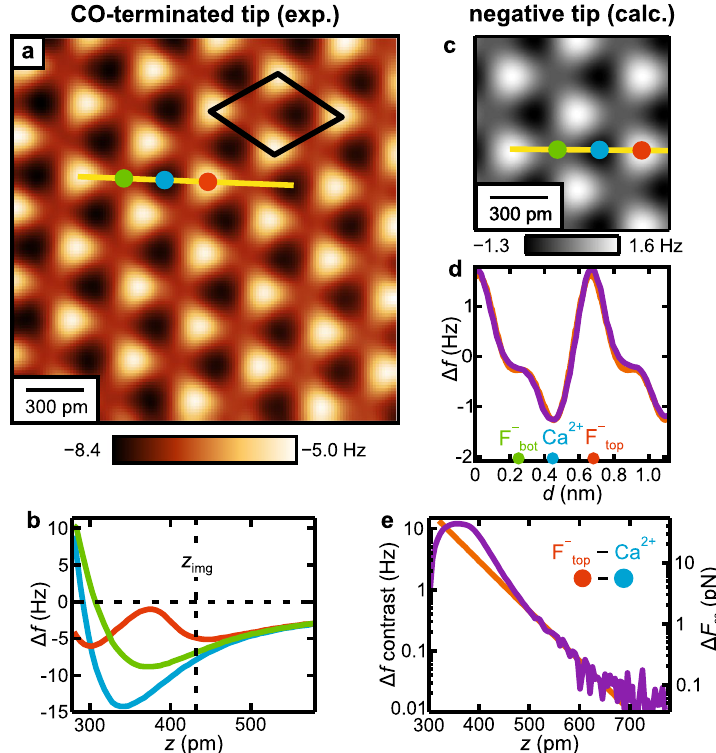
Figure 6. ( a ) Experimental constant-height (cid:31) f image of the CaF 2 (111) surface recorded with a CO-functionalized tip, processed with a 78 pm × 78 pm Gaussian low-pass filter 44 . The unit cell defined in Fig. 1f is drawn black in the image. ( b ) Experimental � f ( z ) curves recorded above the three high-symmetry sites marked in ( a ). The constant-height image [( a )] has been recorded at the tip-sample separation z img . ( c ) Calculated constant-height (cid:31) f image for a negatively-terminated tip using the electrostatic point charge calculation. ( d ) Comparison of experimental (purple) and and calculated (orange) line profiles following the traces in the respective images [( a ) and ( c )]. To align the experimental to the calculated data, the average over one period of the profile has been subtracted from each curve. Note that the overall (cid:31) f contrast in ( a ) is slightly higher than in the line profile shown in ( d ). This can be attributed to the fact that the imaging plane is not perfectly aligned with the sample, leading to a slightly darker contrast in the top left corner as compared to the brighter bottom right corner. ( e ) Comparison of experimental and calculated � f ( z ) contrasts, together with the calculated electrostatic force contrast (cid:31) F es